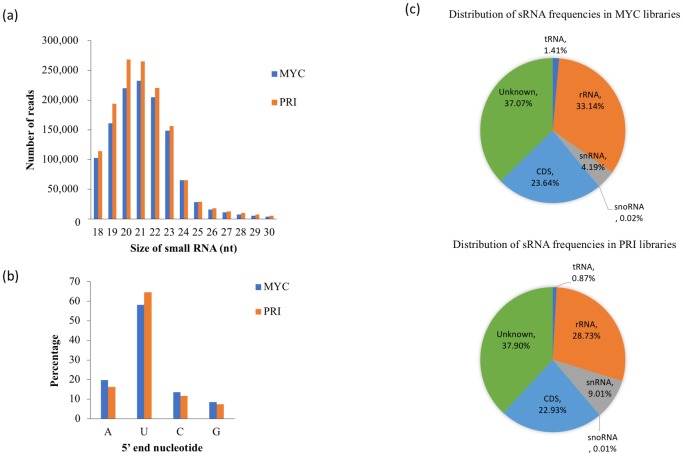
Features of sRNAs uncovered in C. cinerea.(a) Size distribution and (b) 5’ end nucleotide frequency of sRNAs in mycelial (MYC) and primordium (PRI) stages. (c) Pie charts showing the distribution of sRNA frequencies in two MYC and PRI libraries.